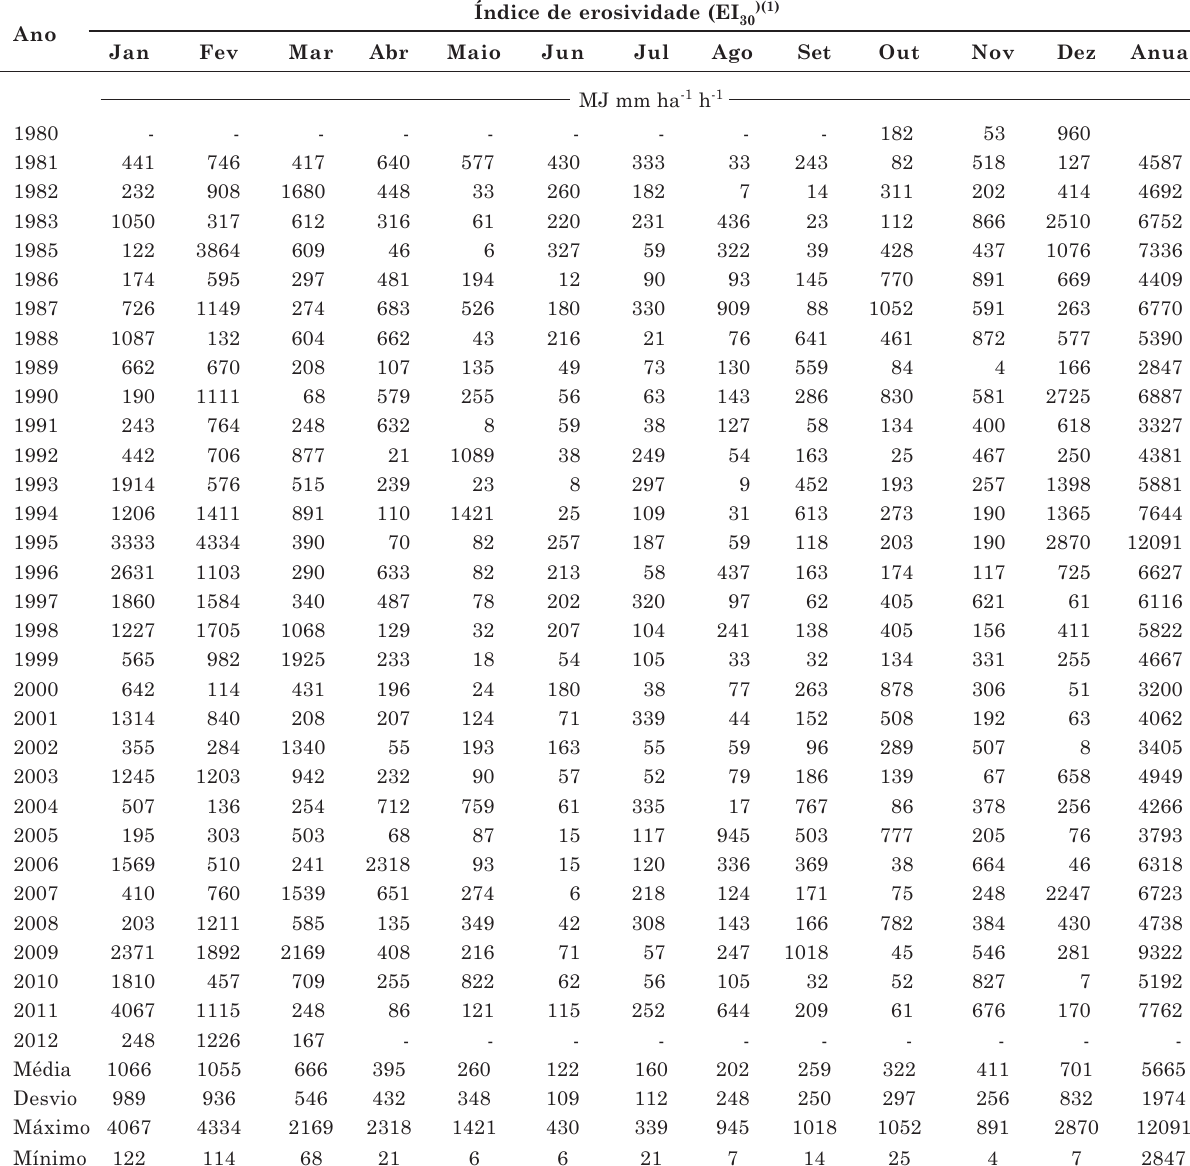
Quadro 2. Valores mensais e anuais do índice de erosividade EI 30 , com dados pluviográficos de Urussanga, SC, com os respectivos parâmetros